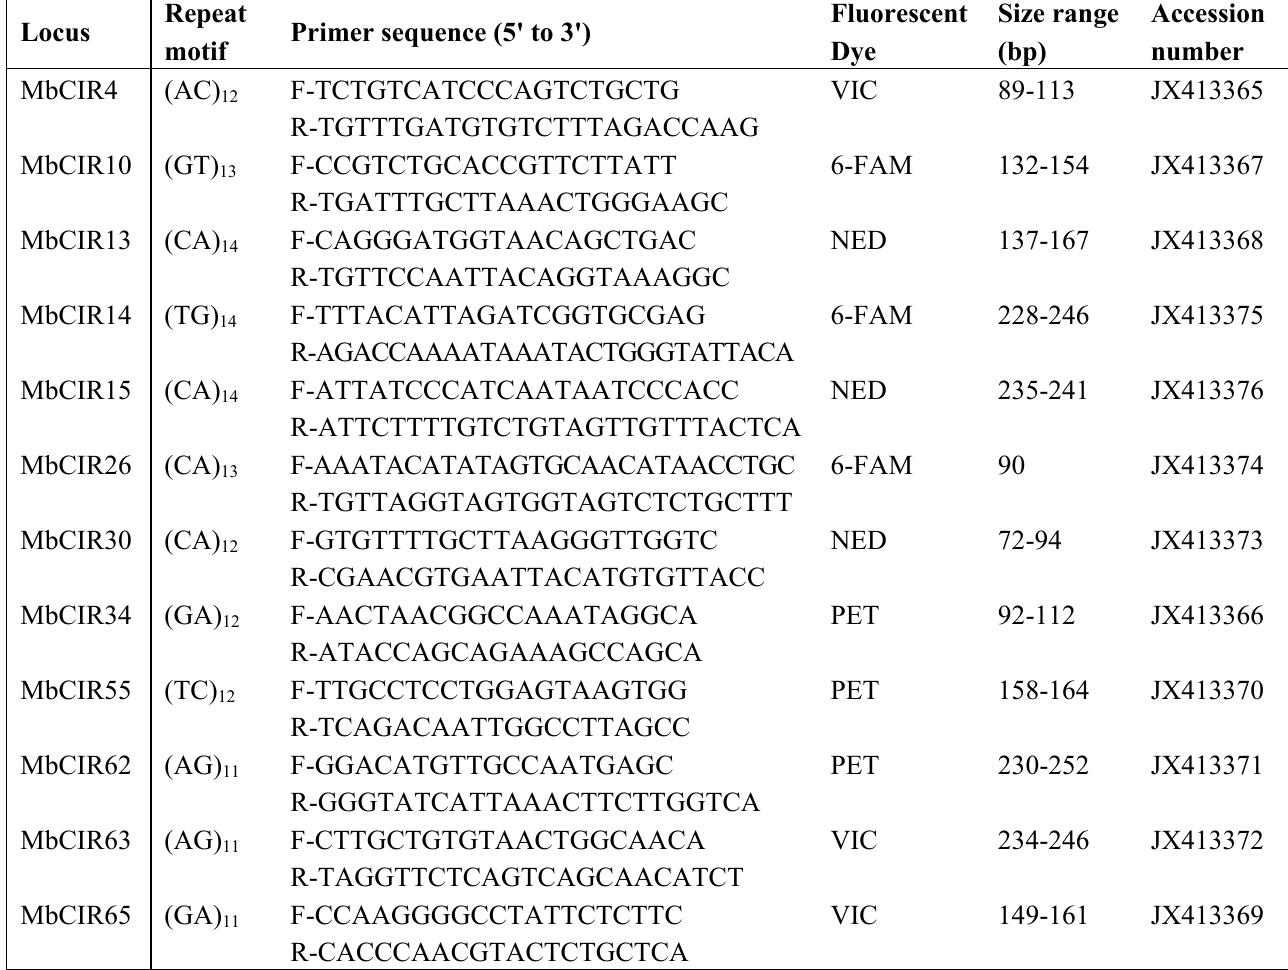
Table 1. Characteristics of twelve microsatellite loci developed for the tree species Mimusops balata .